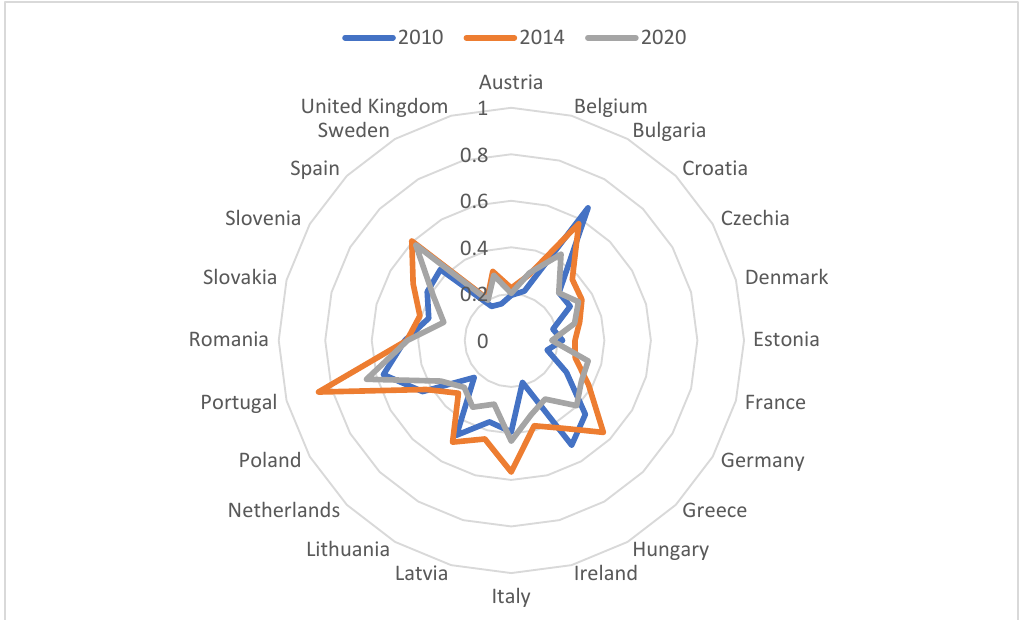
Figure 1. The average energy poverty level for 25 EU countries in 2010, 2014 and 2020.